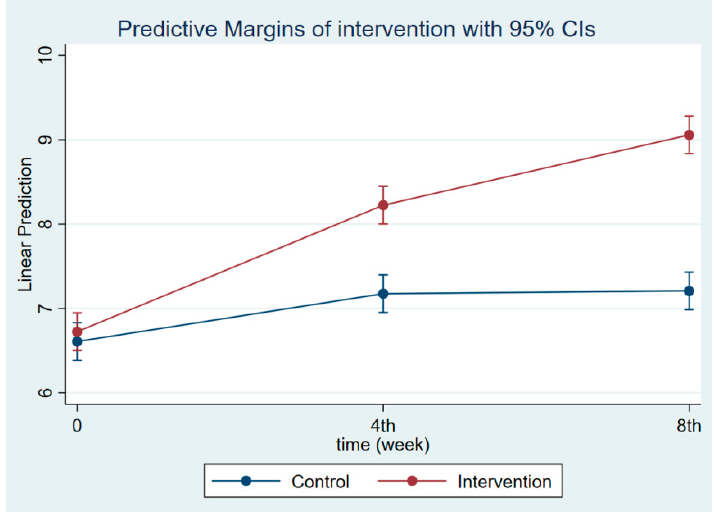
Figure 3. Maternal knowledge regarding CDM at follow-ups 1 and 2.